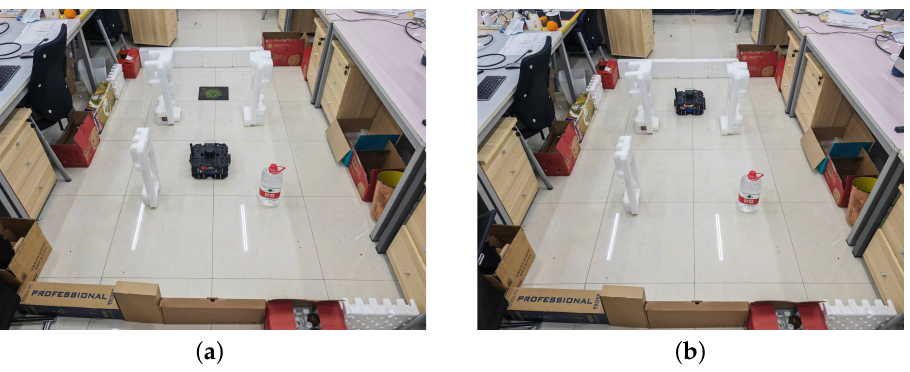
Figure 16. Robot performs path planning in real environments. ( a ) Initial Environment. ( b ) Robot arrives at target